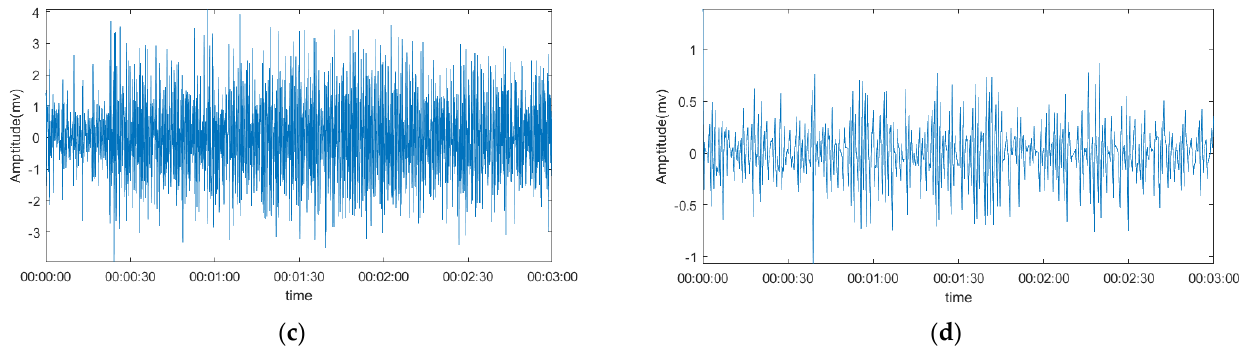
Figure 4. The outcome of the MPCA denoising process. ( a ) The original signal of channel 1. ( b ) The denoising signal of channel 1. ( c ) The original signal of channel 2. ( d ) The denoising signal of channel 2.